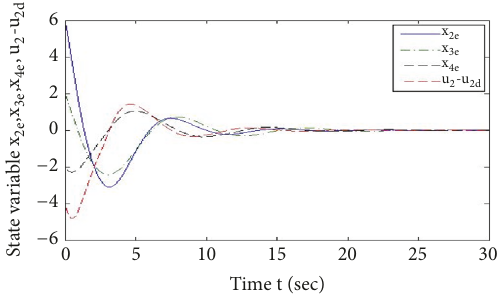
Figure 5: The response of state variable ( 𝑥 2𝑒 , 𝑥 3𝑒 , 𝑥 4𝑒 , 𝑢 2 − 𝑢 2𝑑 ) with respect to